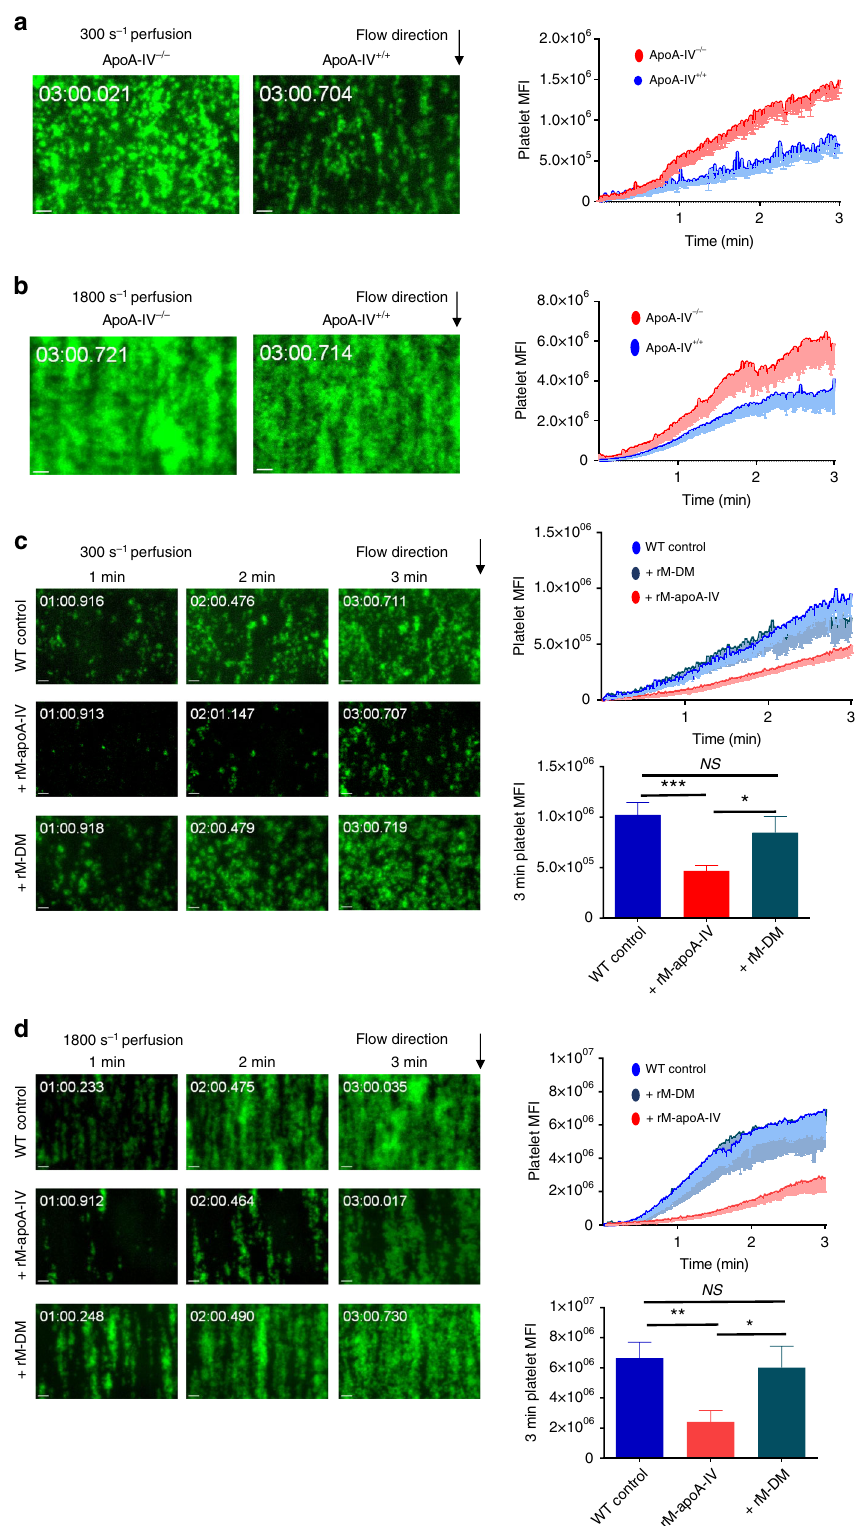
Fig. 5 ApoA-IV inhibits mouse thrombus growth in vitro. a Enhanced thrombus formation in blood from apoA-IV − / − mice under low shear rates. b Enhanced thrombus formation in blood from apoA-IV − / − mice under high shear rates. c , d Inhibition of thrombus formation in blood from WT mice by recombinant mouse apoA-IV under low shear ( c ) and high shear ( d ), while double D mutations abolished its inhibition. Representative images of thrombus formation (green) in four individual experiments were shown. n = 9 – 12 thrombi. Unpaired, two-tailed Student ’ s t -test or non-parametric Kruskal – Wallis one-way analysis of variance for multiple paired comparisons. Mean ± SEM. NS not signi fi cant, * P < 0.05, ** P < 0.01 and *** P < 0.001. Scale bars: 10 μ m ( a – d